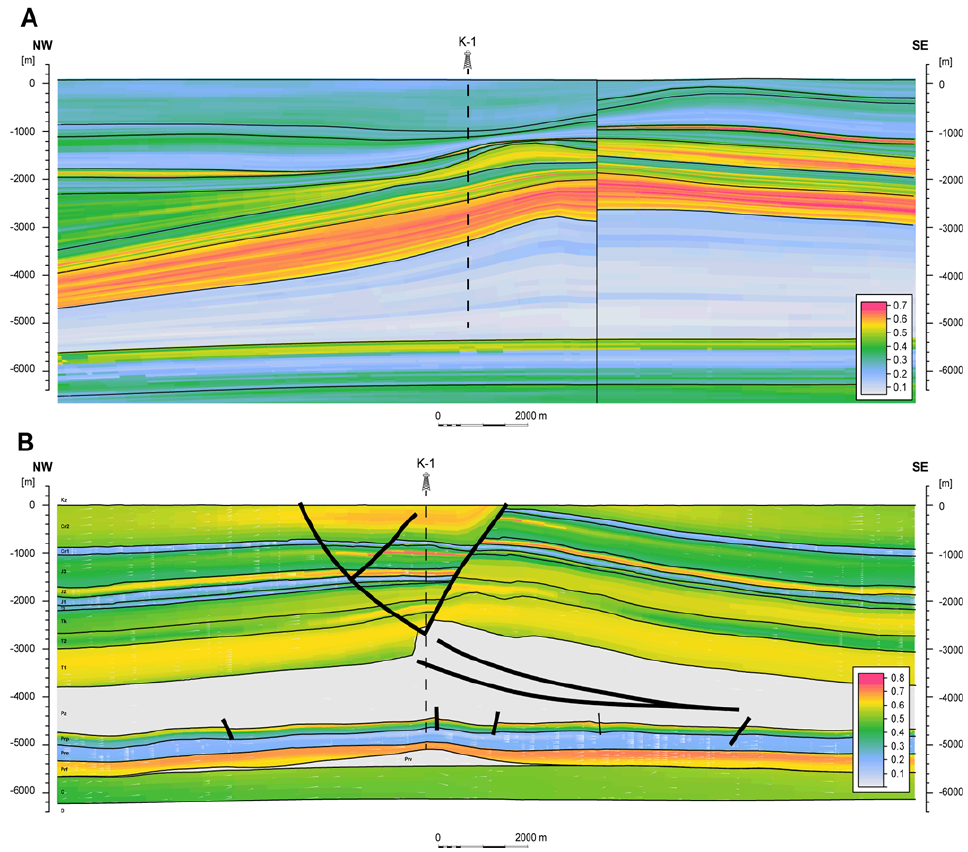
Figure 13. Distribution of the shale volume (VSH) along the NW–SE cross-sections: ( A ) upper part, SMV1; ( B ) lower part, SMV2.